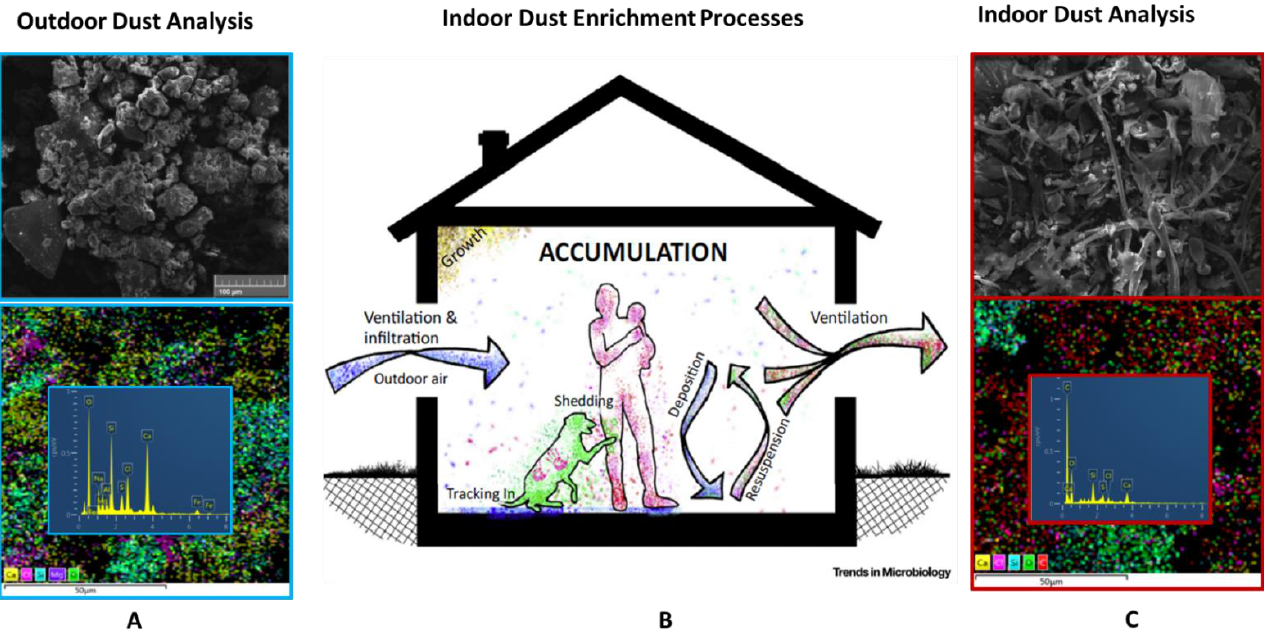
Figure 1. The outdoor dust particles after entering the built environments (BEs) turn more polluted owning to human-mediated activities. Figure Legend: Influx of dust particles ( A ) that interact with human subjects, and human- and animal-mediated microbial communities inside built environments ( B ). Food particles, released human skin, hair and many indoor activities cause the loading of captured dust with diverse entities of a chemical and biological nature ( B ): adapted from Trends in Microbiology [7]). Scanning electron microscopic (SEM) images of indoor dust with weird structures such as skin pigment, human and animal hair, fabric material, food particles, heavy metals, as well as microbes ( C ). Scanning electron microscopy (SEM, TESCAN VEGA, LMU) coupled with energy-dispersive X-Ray spectroscopy (EDX, INCAx-act, Oxford Instruments, Abingdon-on-Thames, UK) was used as a case study example to analyze the surface morphology and elemental composition of the dust samples ( A , C ). EDX analysis showed typical inorganic elements, mainly O, Si, Ca, Al and Fe ( A , B : lower panels). Panels A and C are a courtesy of Dr. Cijo Xavier, Newcastle University, while Panel B is adopted from [7].